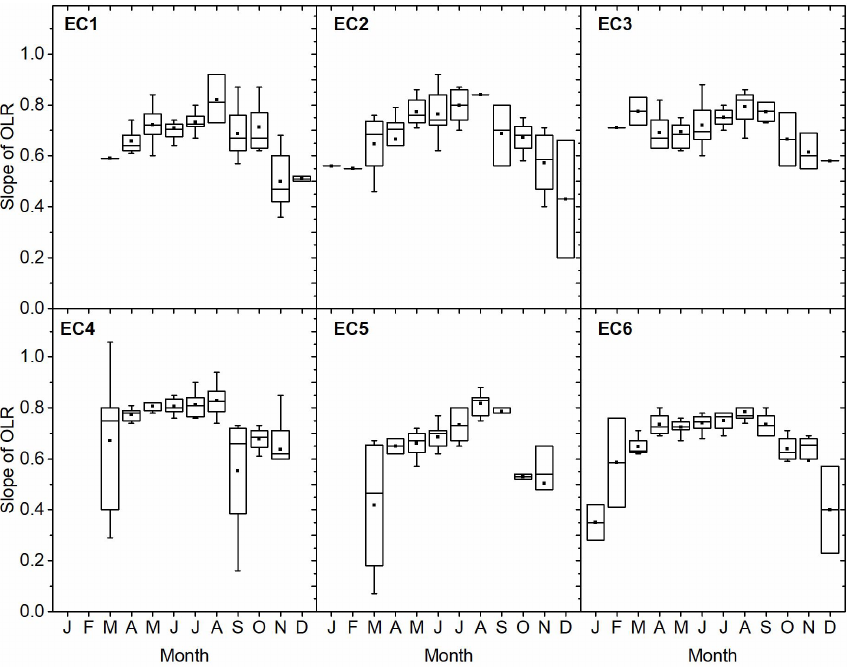
Figure 5. Monthly aggregated energy balance closure (EBC) obtained by ordinary linear regression of turbulent fluxes (LE + H) against available energy ( R n − G) for all stations during 2010–2017.